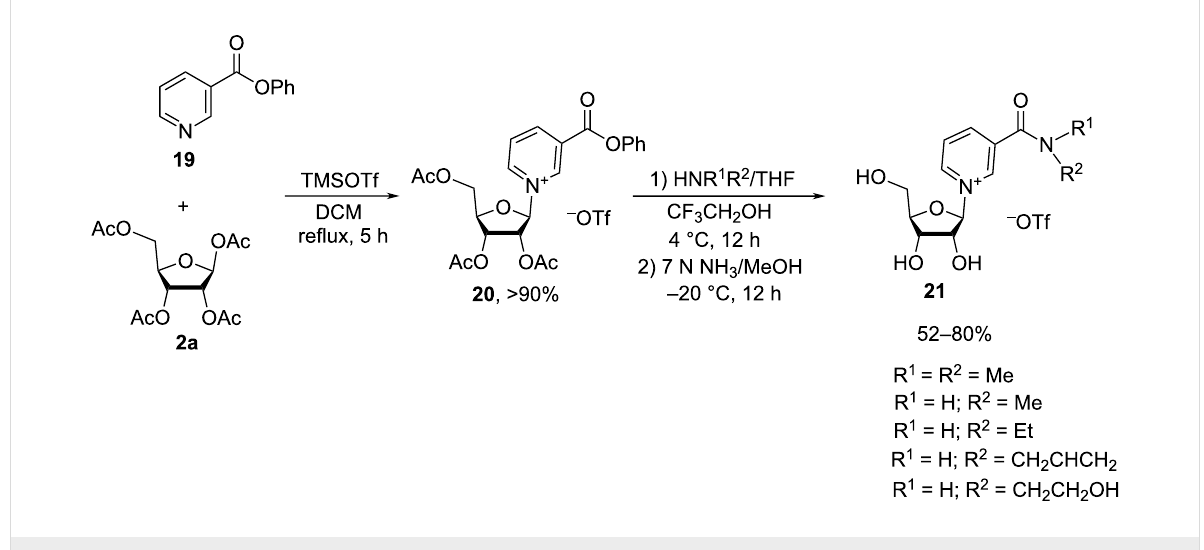
Table 1: Summary of the syntheses of triacylated nicotinamide (or ethyl nicotinate) riboside salts 2,3,5-triacyl-NR + X ˉ (or 2,3,5-triacyl-NAR + X ˉ ) and nicotinamide riboside salts NR + X ˉ . starting reagents glycosylation reaction conditions: deacylation reaction solvent/temp/time, conditions Lewis acid